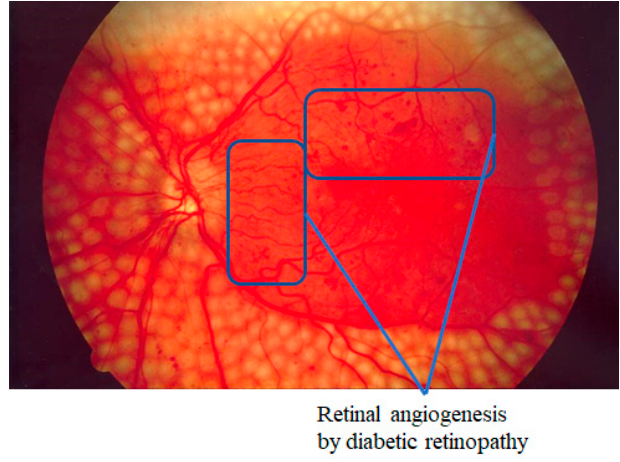
Figure 3. Example of angiogenesis by diabetic retinopathy.